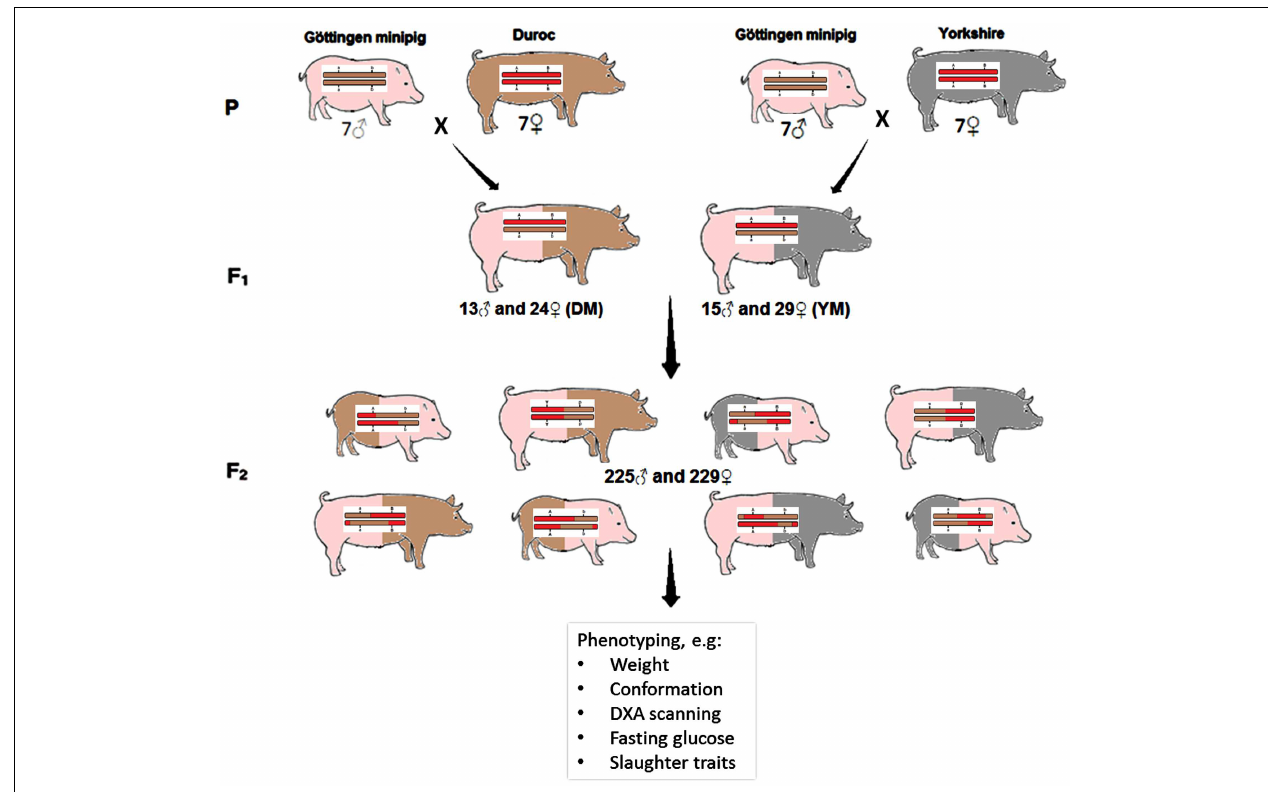
FIGURE 1 | Overview of the experimental design. The resource population consisting of 454 F2 pigs was created and extensively phenotyped using a cross between lean production pigs (Yorkshire/Duroc) × Göttingen minipig.